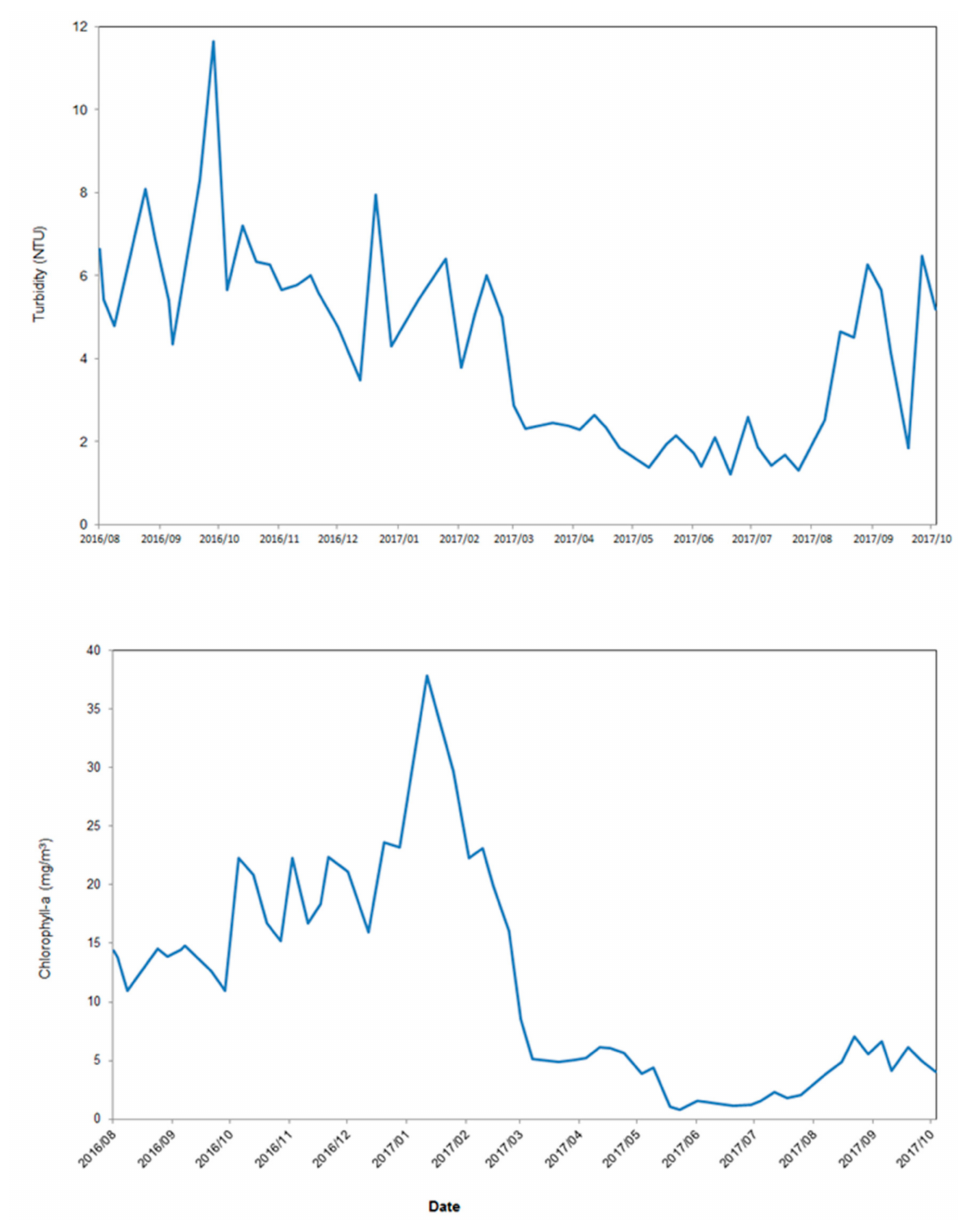
Figure 3. Turbidity in Nephelometric Turbidity Units (NTU) and chlorophyll-a concentration (mg / m 3 ) time